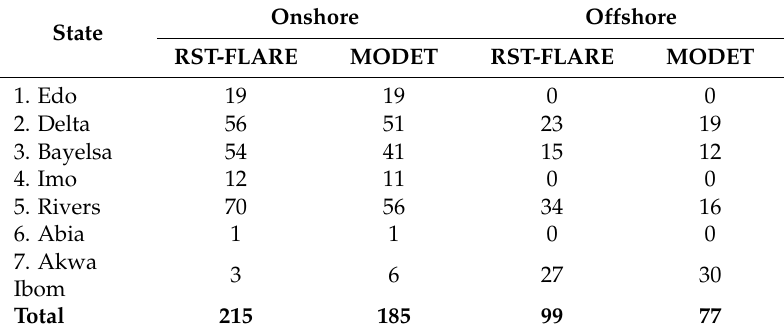
Table 3. Distribution of flaring sites detected, onshore and offshore, by RST-FLARE and MODET (source: Table 4 in [12]) across the seven Niger Delta states. Onshore State